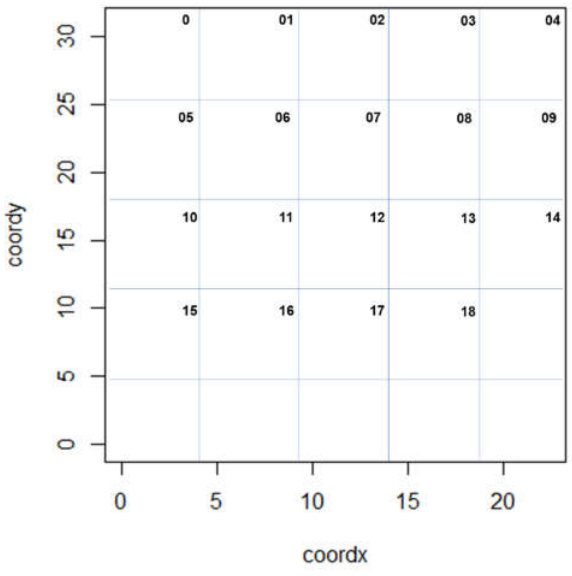
Figure 1. Grid sketch for the positioning animal assessment.